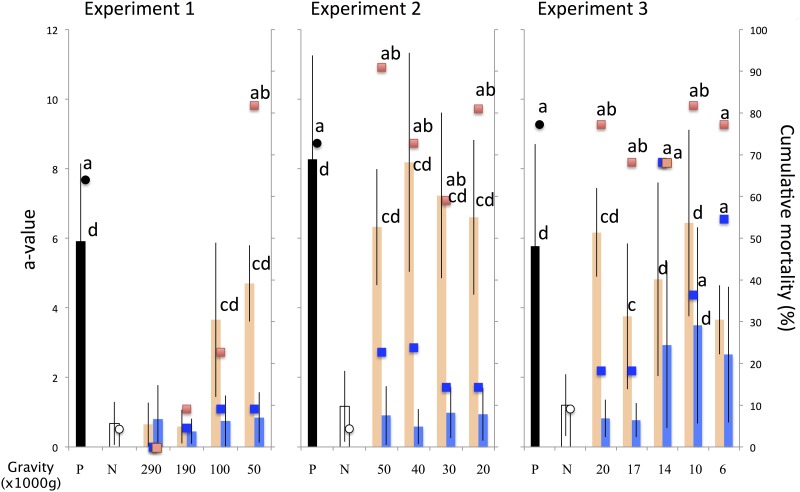
Survivor adductor muscle a-value (bars) and cumulative mortality (plotted points) are shown for each group.The groups are color coded as follows: positive control, black; negative control, white; sediment-inoculated groups, orange; and supernatant-inoculated groups, blue. Letters indicate statistically significant differences: a, cumulative mortality significantly different from the negative control (Fisher's exact test, p<0.05); b, cumulative mortality significantly different from the supernatant-injected group (Fisher's exact test, p<0.05); c, mean a-value significantly different from the supernatant control (Wilcoxon signed-rank test, p<0.05); and d, mean a-value significantly different from negative control (Wilcoxon signed-rank test, p<0.05).